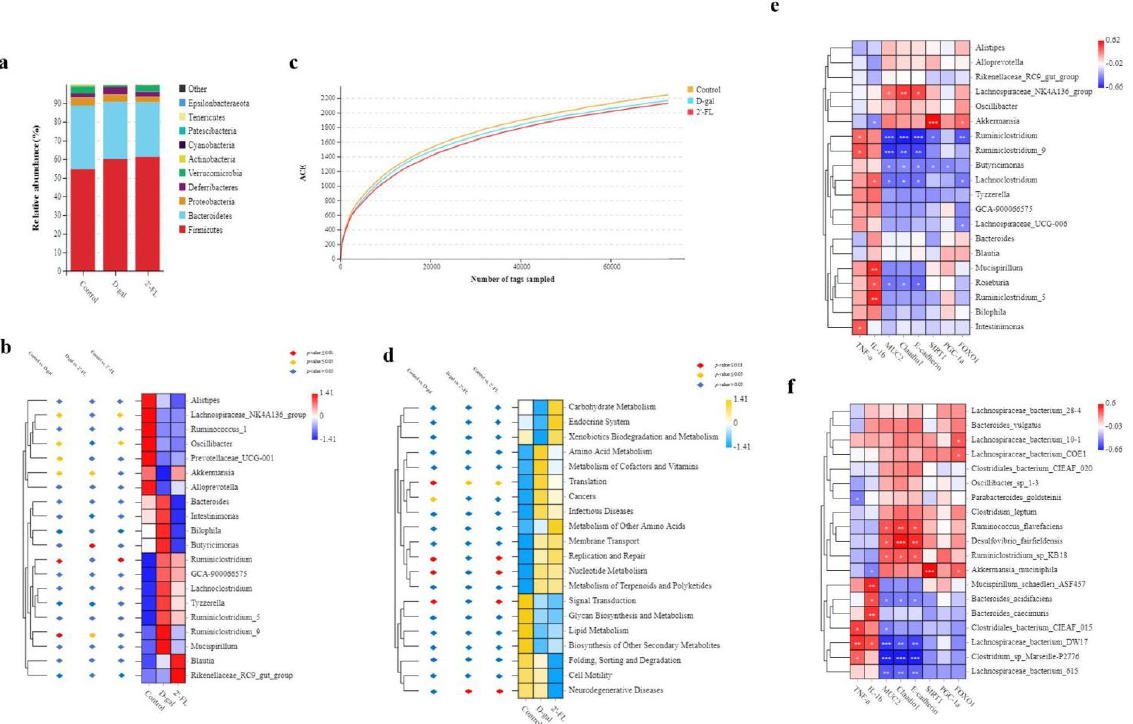
Figure 5. Analysis of the gut microbiota in all three groups. ( a ) The level of phylum. ( b ) The level of genus. ( c ) Dilution curve. ( d ) Tax4Fun analysis in level 2 based on the SILVA database. ( e ) Pearson analysis at the genus level. * p < 0.05, ** p < 0.01, and *** p < 0.001. ( f ) Pearson analysis at the species level. * p < 0.05, ** p < 0.01, and *** p < 0.001.